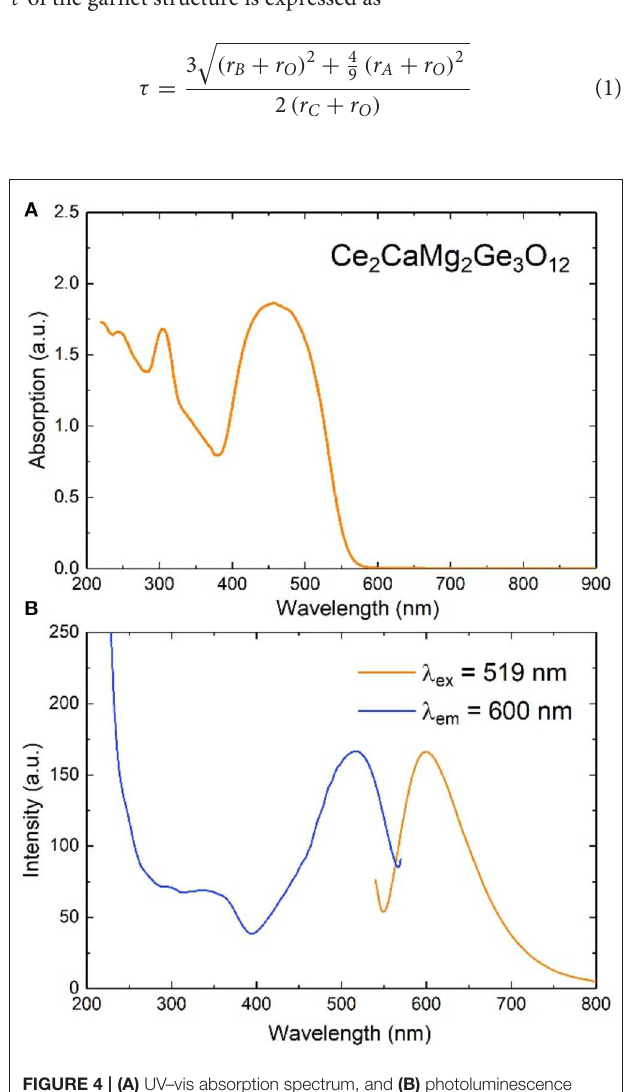
FIGURE 6 | Most stable configurations of Ce 2 CaMg 2 Ge 3 O 12 found by a series of first principles calculations in the present study. Search conditions are described in the main